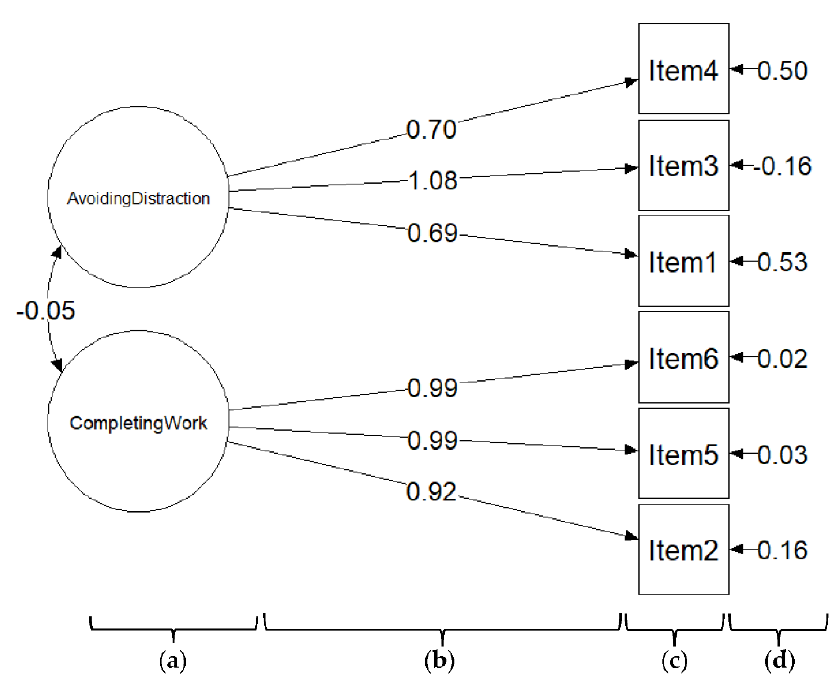
Figure 2. The two ‐ factor model of the CSPS ‐ 6 according to a confirmatory factor analysis. ( a ) CSPS ‐ Figure 2. The two-factor model of the CSPS-6 according to a confirmatory factor analysis. ( a ) CSPS-6 6 factors; ( b ) standardized factor loading; ( c ) CSPS ‐ 6 items; ( d ) error variance. factors; ( b ) standardized factor loading; ( c ) CSPS-6 items; ( d ) error variance. Table 3. Correlations between the CSPS-6 and the health